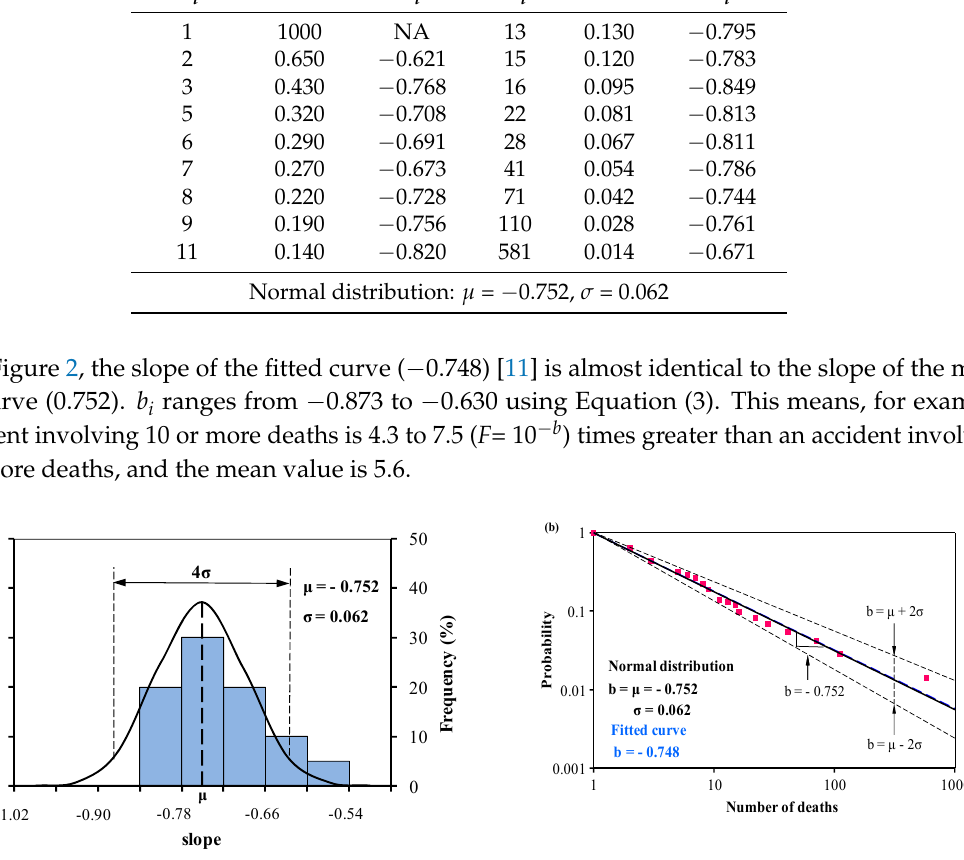
Table 2. Accumulated frequency of rail accidents with N deaths digitized from Oggero et al. [11]. N i